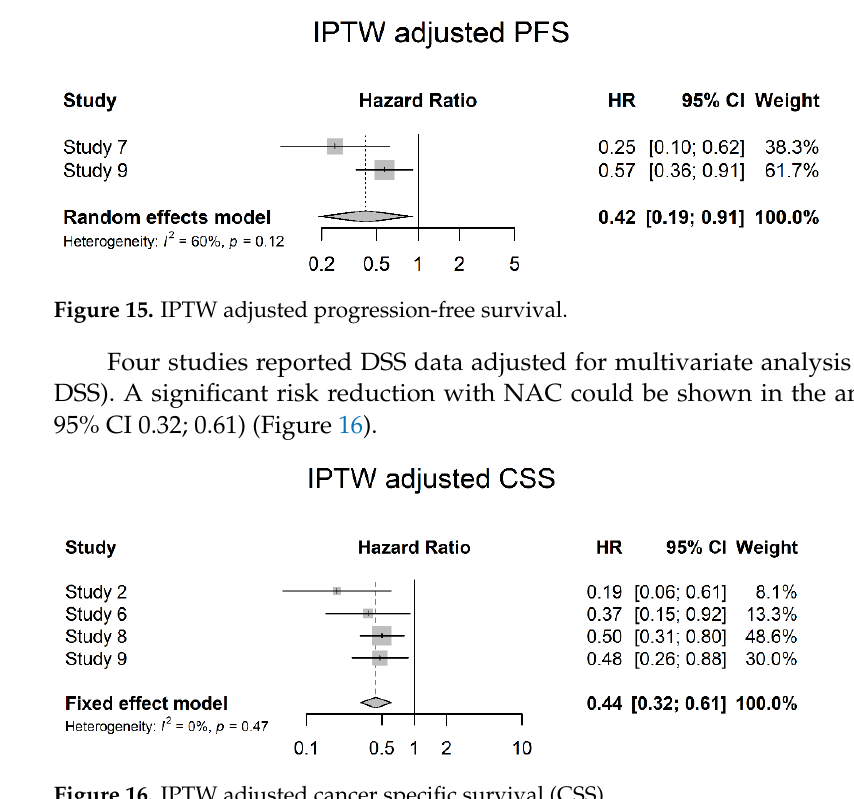
Figure 16. IPTW adjusted cancer specific survival (CSS).